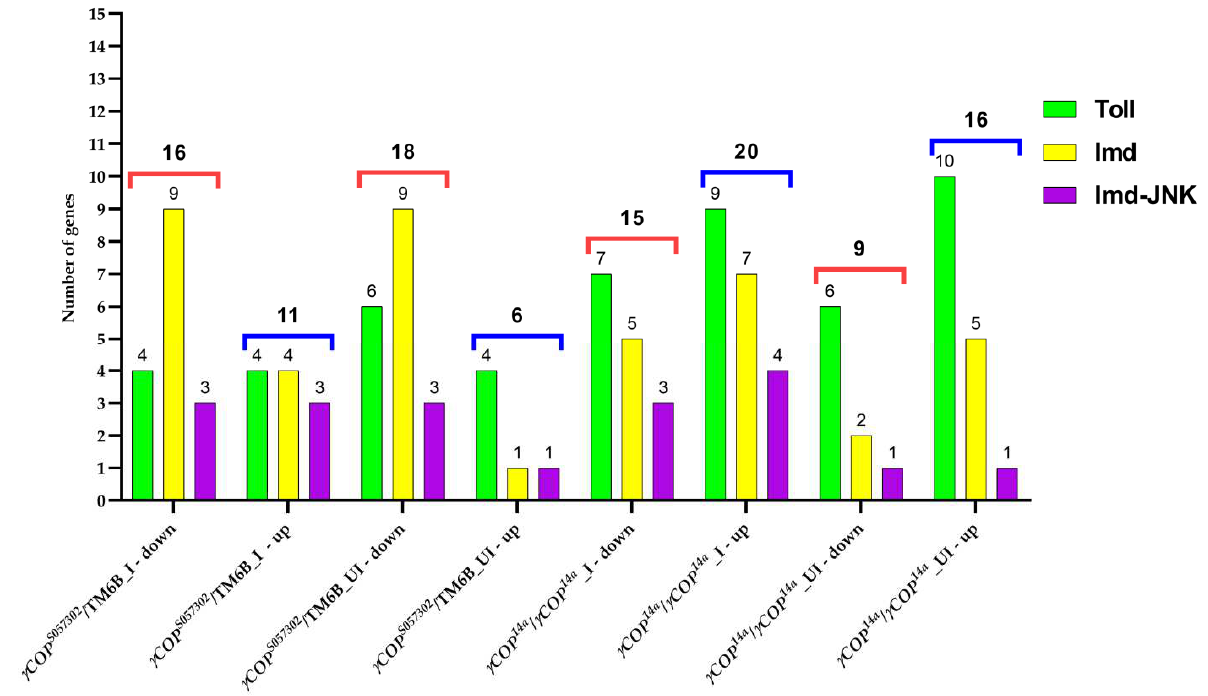
Figure 2. An overview of the differential expression of immune genes in γCOP mutant males. For every infected (I) or uninfected (UI) experimental condition, we counted the number of genes pertaining to Imd, Toll, and Imd-JNK pathways that were significantly down- or upregulated. Red (for downregulated genes) and blue (for upregulated genes) lines are highlighting the differences between the I/UI heterozygous and homozygous